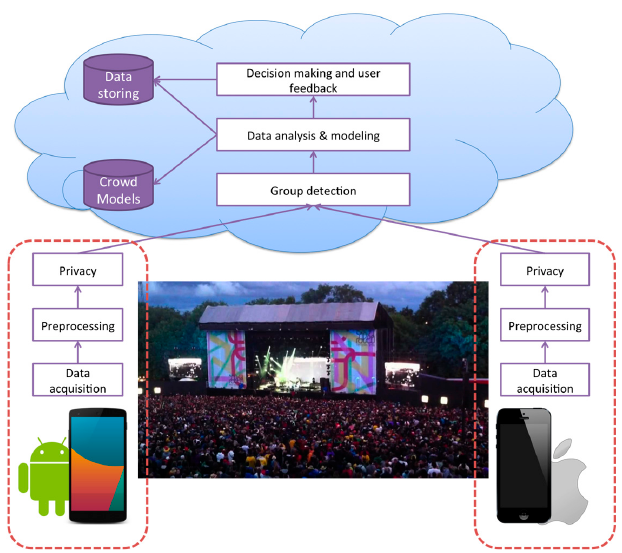
Figure 4. SmartCrowd app structure. The red dashed lines regroup the modules developed within the mobile app.